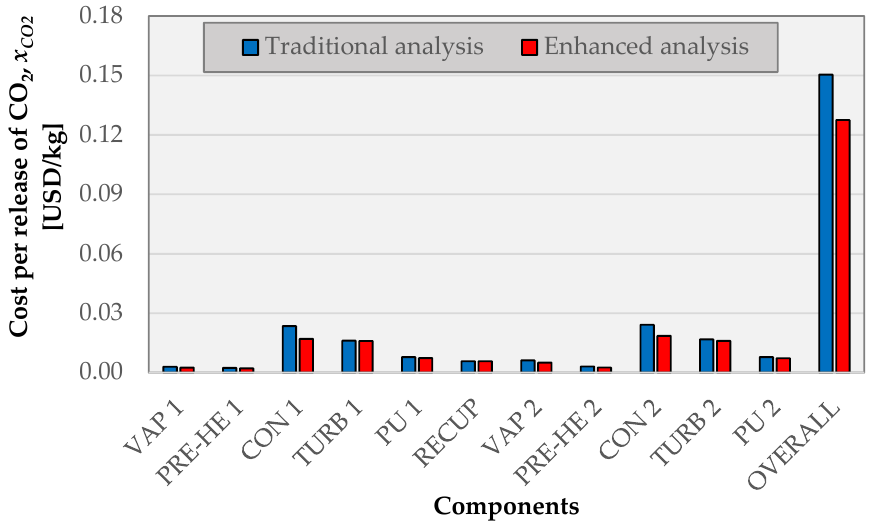
Figure 9. Change in cost per release of CO 2 for the components for both analyses.